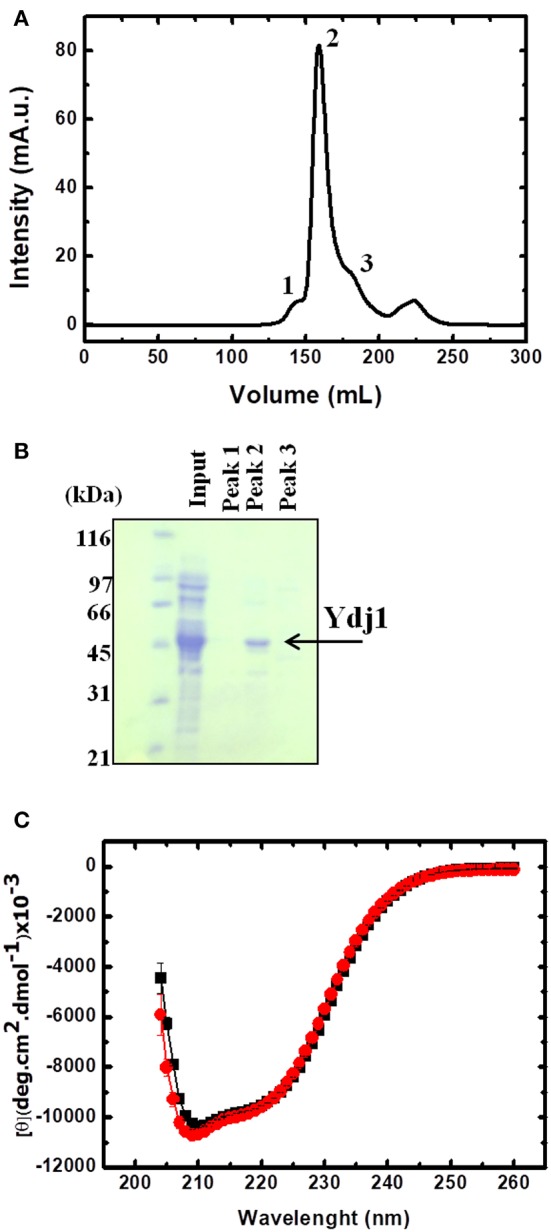
Production and purification of folded Ydj1. (A) Chromatogram of the last purification step. Peaks were labeled 1 to 3 and verified by SDS-PAGE (B). Sample from peak 2 contained purified Ydj1. Molecular mass standard is on the left. (C) Folded Ydj1 was produced, as verified by its far-UV CD spectrum (red). Ydj1 remained folded after the Zn removal procedure (see text for details), as verified by its far-UV CD spectrum (black).